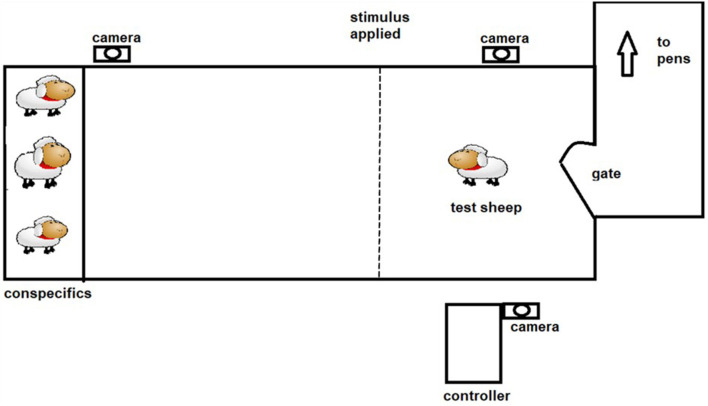
The laneway set up for individual testing and training of sheep.